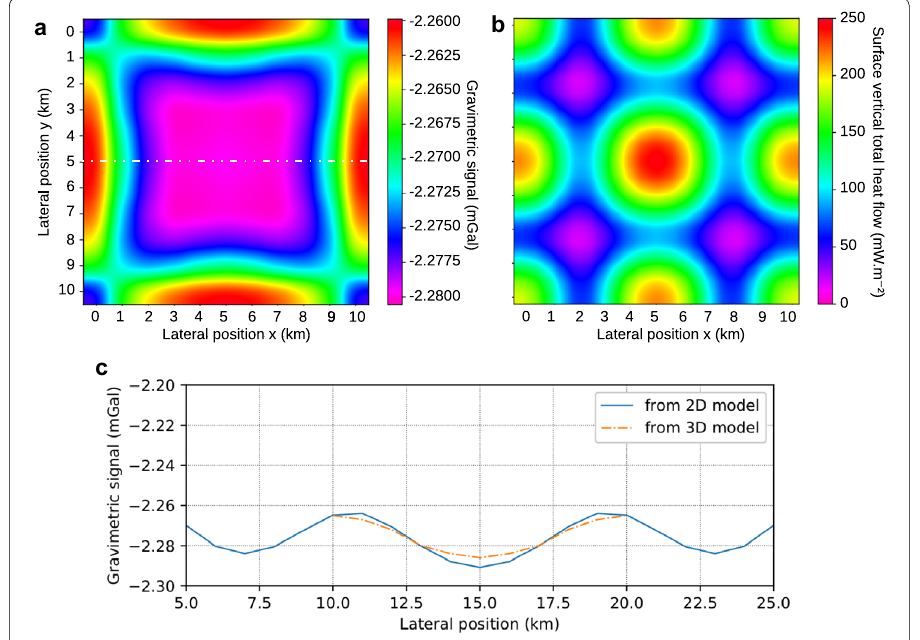
Fig. 7 a Map of gravity anomaly from the 3D Soultz model. The white dotted line corresponds to the position of the profile extracted from the 3D model for c . b Associated map of vertical total heat flow extracted at the surface from the 3D Soultz model. c Comparison of gravimetric profile along the x -axis between the 2D and 3D